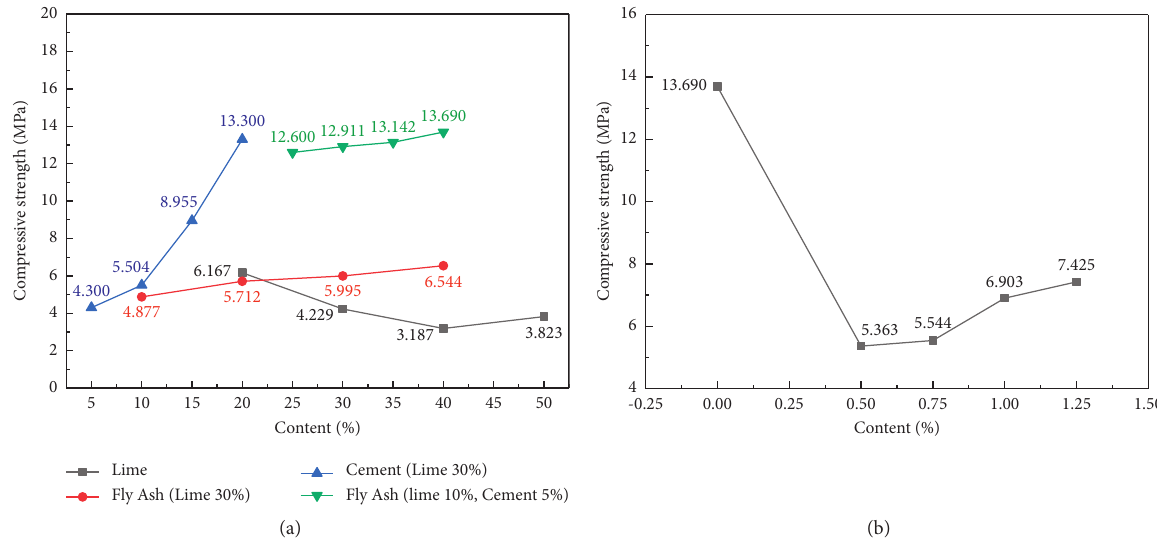
Figure 3: The influence of lime, fly ash, cement (a), and polyvinyl alcohol (muck 45%, lime 10%, cement 5%, and fly ash 40%) (b) on tensile